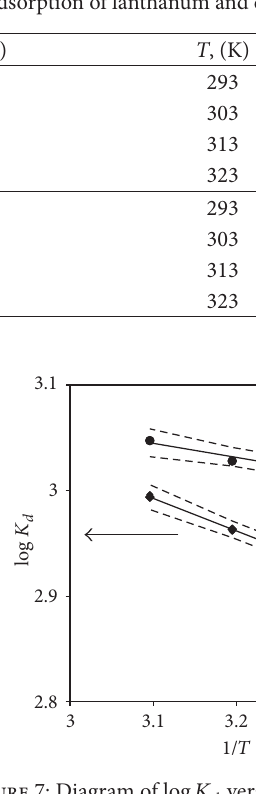
F 7: Diagram of log